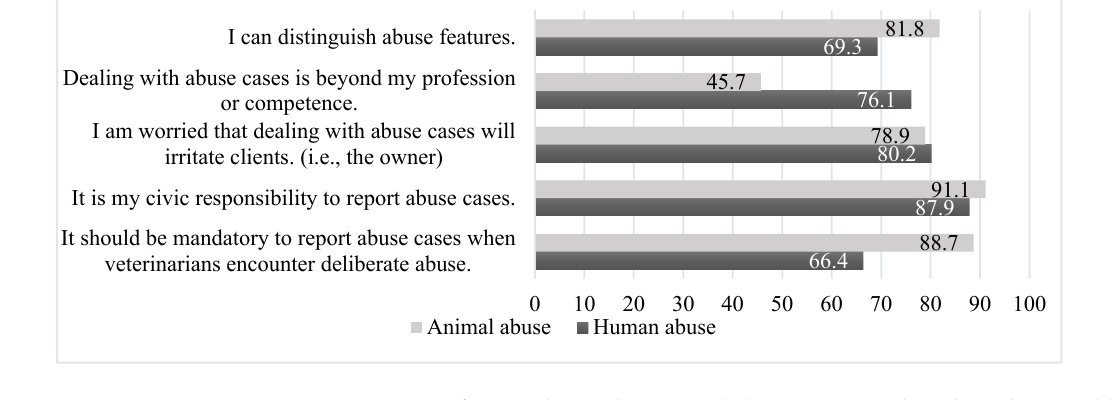
Figure 1. Percentages of respondents who responded to statements about how they would deal with abuse cases. Table 5. Comparisons of mean scores of item 8 of Section 2 of the questionnaire in Appendix A (“During veterinary training, I was provided with adequate information and training to identify and prevent animal abuse”) among groups segregated by statement and target of